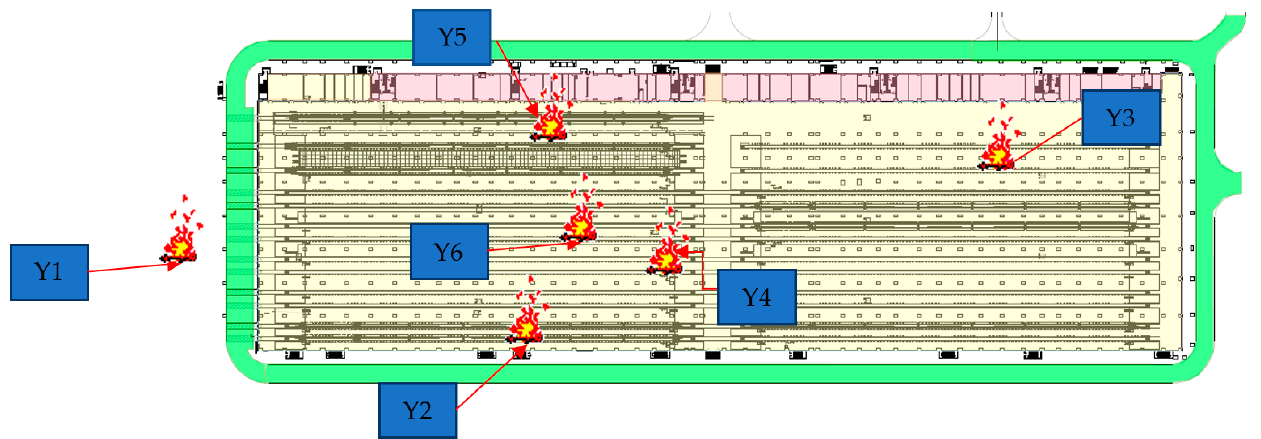
Figure 4. Application library fire scene location map. Smoke scenes in different location were noted from Y1 to